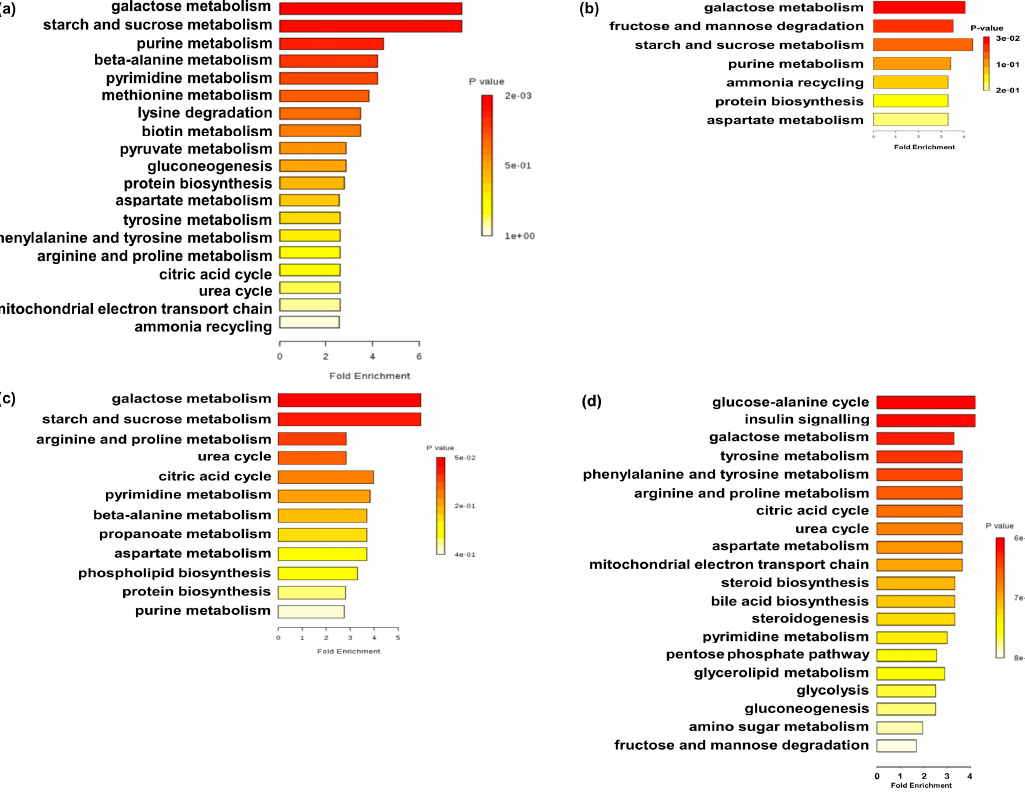
Figure 5. Metabolome view map of the common metabolites (variable importance projection >1.00) identified in the colon in the maternal fecal microbiota transplantation (MFMT), amoxicillin (AM), and control (CO) groups on days 7 ( a , b ) and 21 ( c , d ). The rectangle color is based on the p -value, and the rectangle length is determined from the pathway impact values. Longer lengths and darker colors represent greater pathway enrichment and greater pathway impact values, respectively. ( a , c ) MFMT vs. CO; ( b , d ): AM vs.